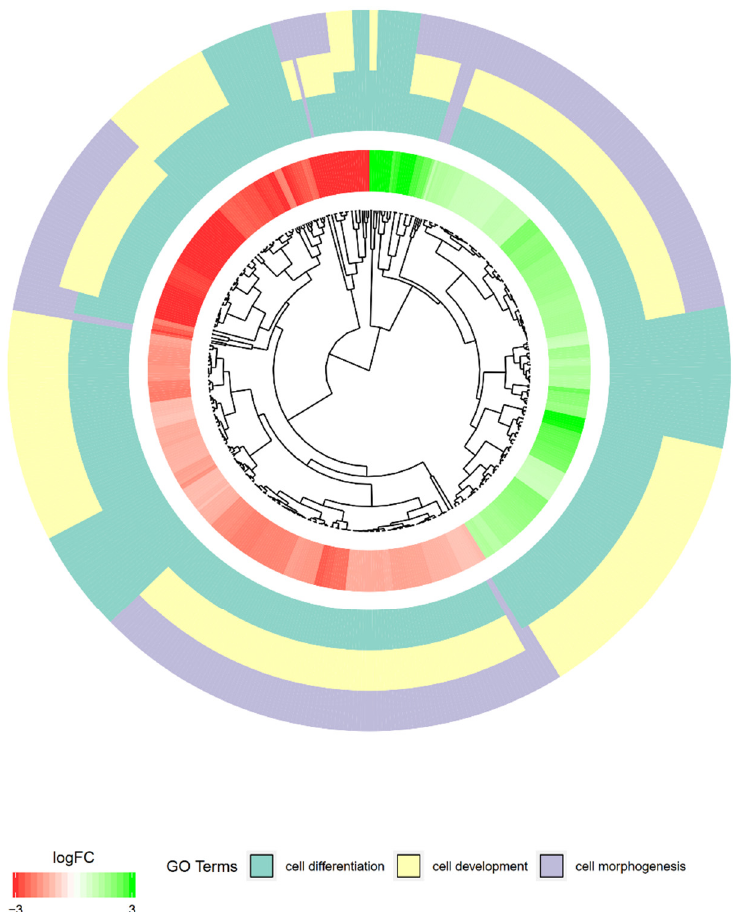
Figure 3. The representation of hierarchical clusterization, fold change and assignment of differently expressed genes that belongs to chosen “cell development”, “cell differentiation” and “cell morphogenesis” GO BP terms. Genes are grouped together based on their expression patterns, with the clusterization pattern represented by dendrogram inside the circle. The middle ring represents the logarithm of gene expression fold change of studied genes. The outer ring represents the terms assigned to the genes.